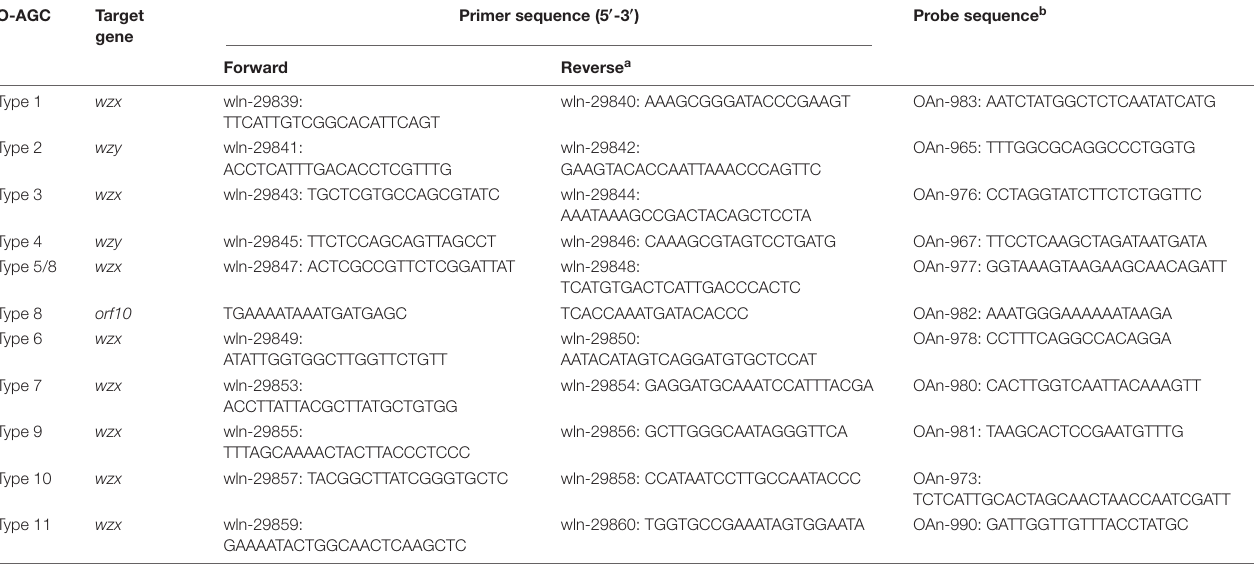
Primer sequence (5 (cid:48) -3 (cid:48) ) Probe sequence